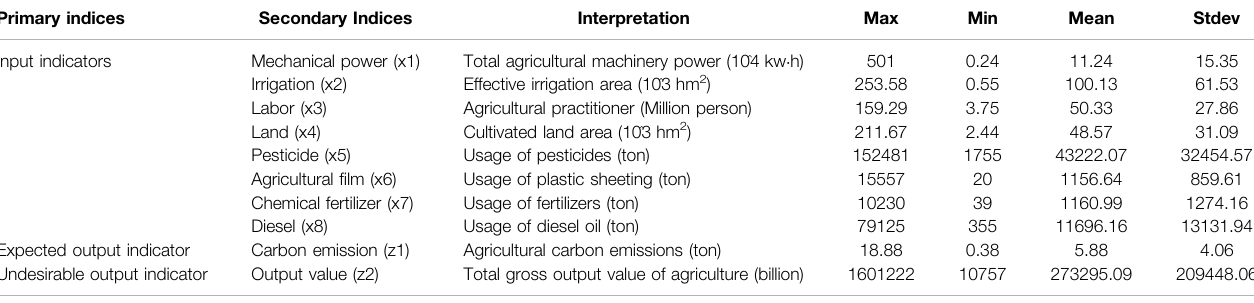
TABLE 1 | The evaluation indicators of agricultural eco-ef fi